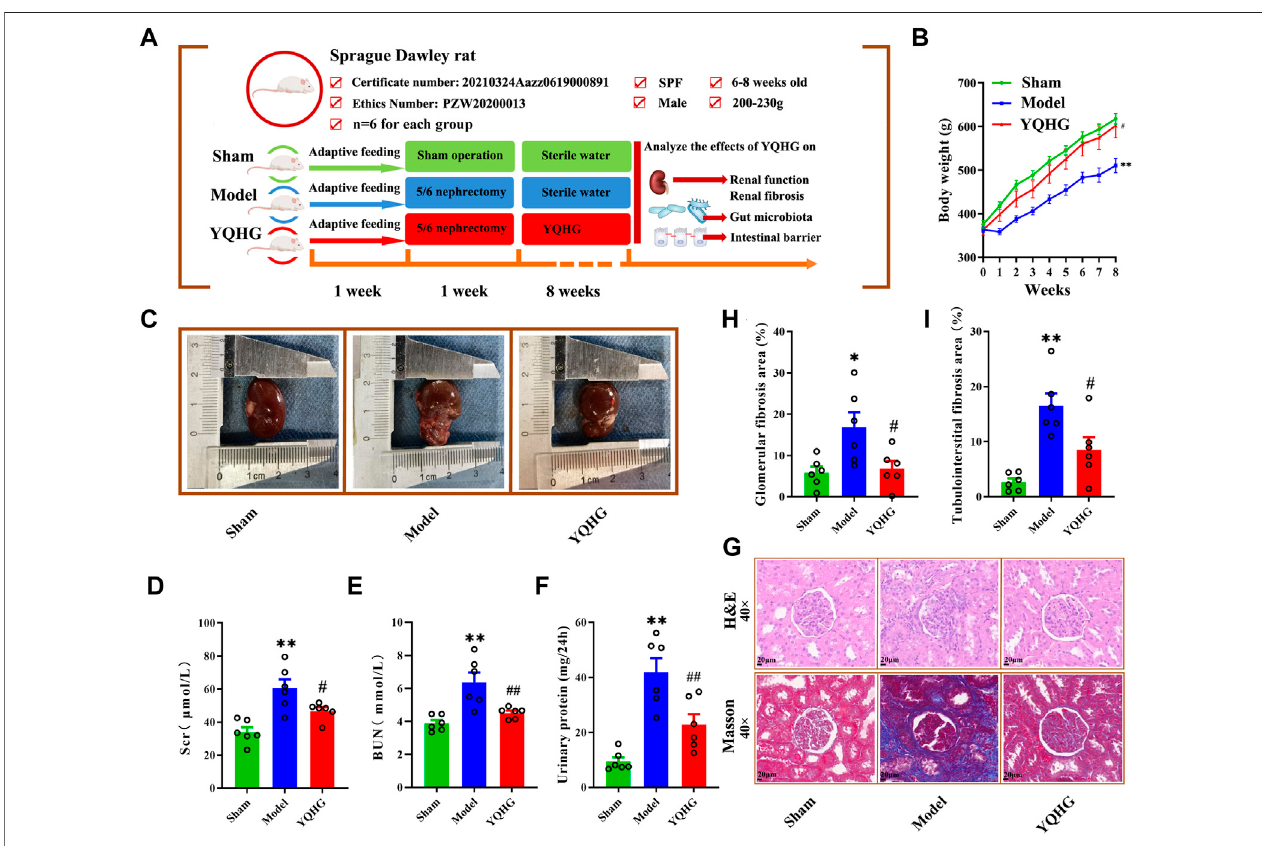
FIGURE 2 | YQHG improves renal function and fi brosis in 5/6 nephrectomized rats. (A) Experimental design. (B) The body weight of the rats was measured. (C) The kidney of the rats was photographed. (D – F) Effects of YQHG treatment on levels of Scr, BUN, and urinary protein in 5/6 nephrectomized rats. (G) Representative images of H&E (40 × Magni fi cation, Scale bar 20 μ m) staining and Masson (40 × Magni fi cation, scale bar 20 μ m) staining of renal tissues. (H – I) Quantitative analysis of glomerular fi brosis area and tubulointerstital fi brosis area based on Masson staining. All data are expressed as means ± SEM. For normally distributed data (body weight, Scr, BUN, urinary protein, glomerular fi brosis area, tubulointerstital fi brosis area), one-way ANOVA followed by Tukey ’ s test was used. * p < 0.05, ** p < 0.01 vs. the sham group; # p < 0.05, ## p < 0.01 vs. the model group.